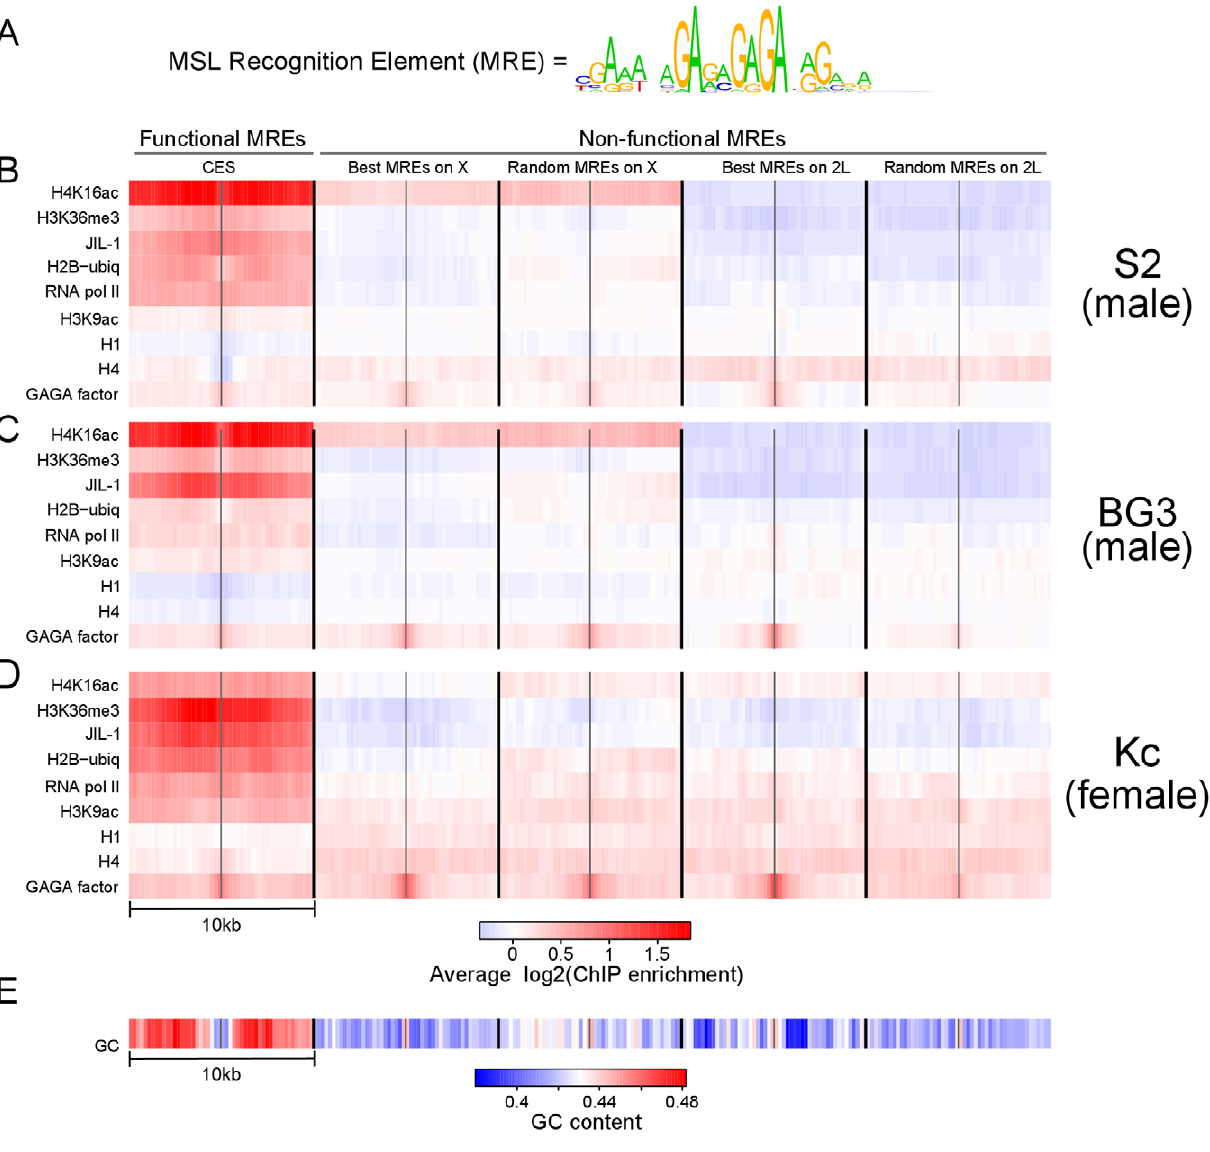
Figure 1. Active chromatin context and elevated GC content are associated with functional MSL recognition elements (MREs) on the X chromosome, independent of MSL binding. (A) The sequence motif for the MRE. (B–D) The average enrichment of various chromatin modifications or chromatin-binding proteins around ( + / 2 5 kb) the functional and non-functional MREs is visualized using a heat map in each of three Drosophila cell lines: S2 in panel B; BG3 in panel C; and Kc in panel D. (E) A heat map showing the average GC content around each class of MREs. The data were obtained from genome-wide ChIP-chip profiles generated as part of the modENCODE project. Many active marks are broadly enriched around functional MREs in both male and female cell lines, suggesting that active chromatin is strongly associated with functional MREs independent of MSL binding. See also Figures S1 and S2.